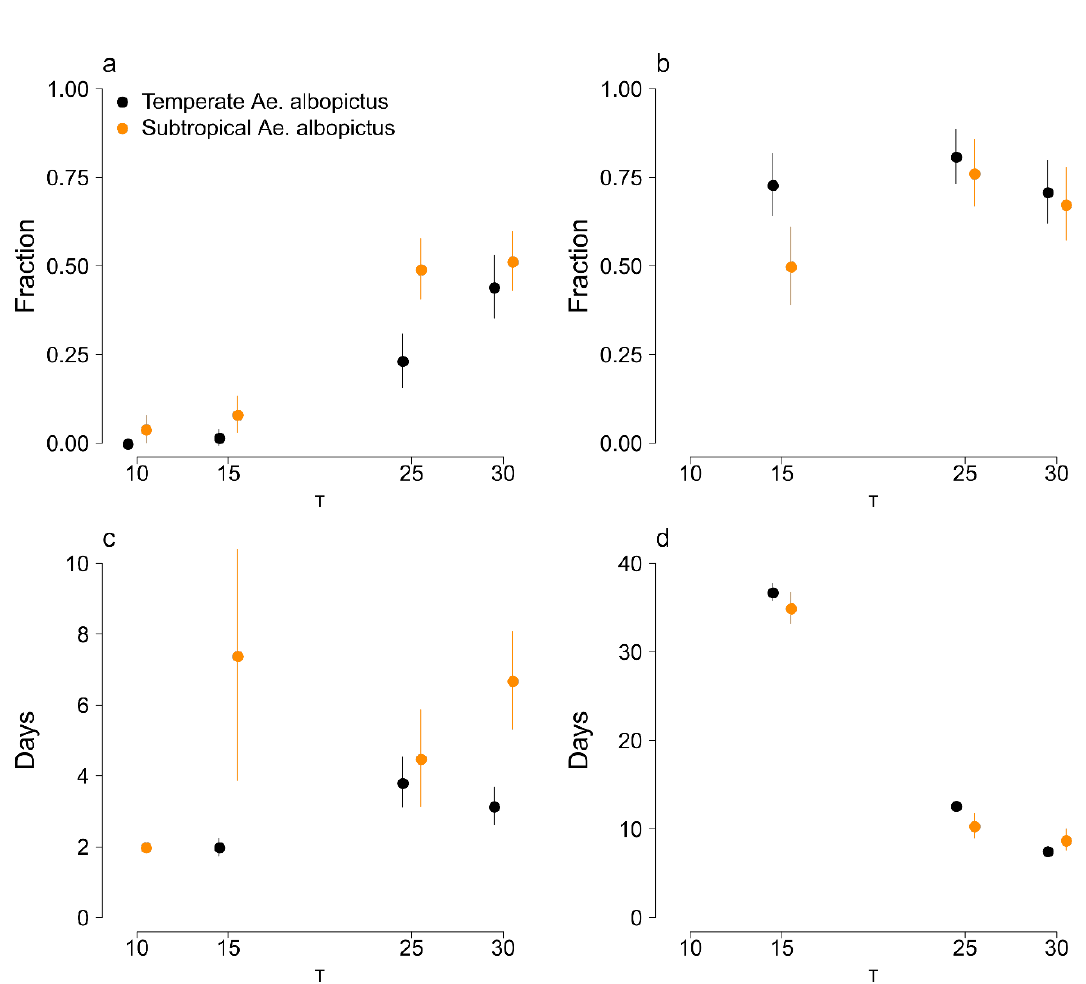
Figure 1. Comparison between temperate Ae. albopictus (black) and subtropical Ae. albopictus (orange) results for each tested temperature (10, 15, 25, and 20 ◦ C). ( a ): Fraction of hatched eggs; ( b ): fraction of L1 larvae that successfully reached the adult stage; ( c ): length of time between immersion of eggs in water and hatching response; ( d ): duration of development from L1 to adult. Points: average values. Vertical lines: 95% Confidence Intervals (average ± 1.96 · SE).